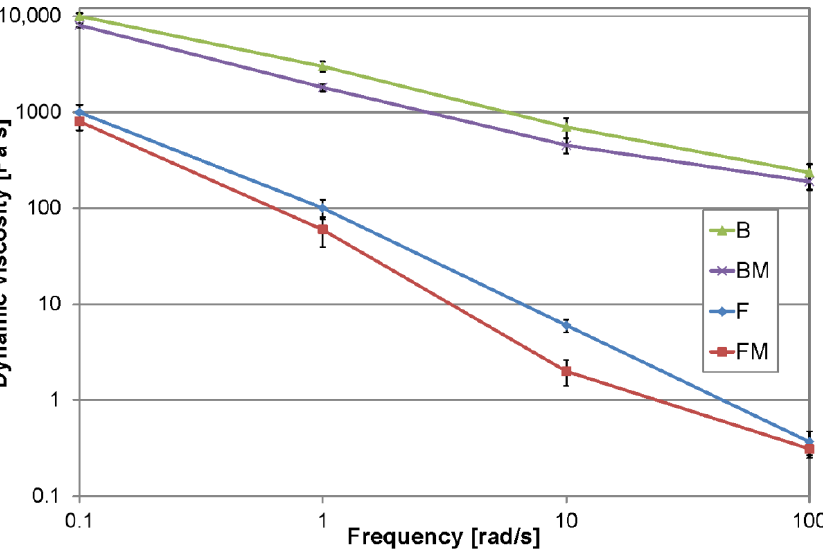
Figure 6. Results of viscosity measurements.